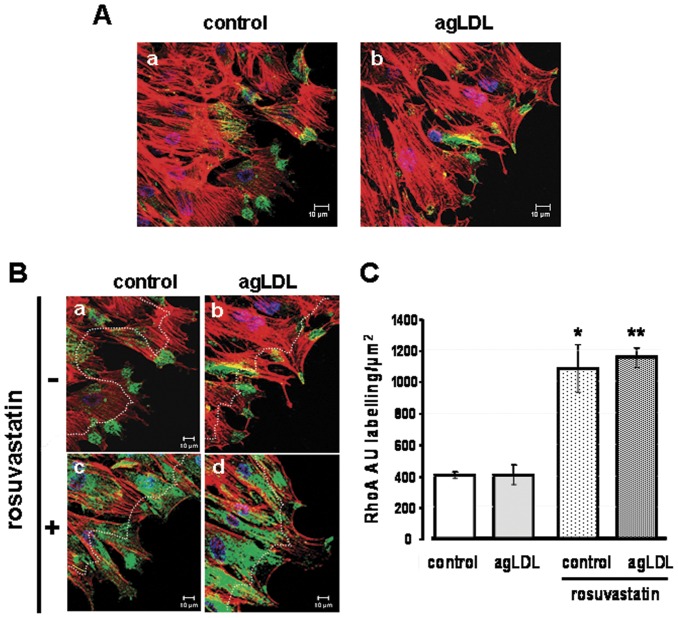
Rosuvastatin increases RhoA at the leading edge of migrating cells.Confocal microscopy for RhoA antigen labelling (green) in migrating cells (FCS-stimulated), 4 hours after the wound scratch. Immunocytology was performed in permeabilized cells. Red signal refers to F-actin (Alexa-Fluor 633 conjugated phalloidin). (A) Representative photomicrographs of RhoA labelling at the wound-border of control cells and agLDL-treated cells. (B) Effect of 10 µM rosuvastatin on RhoA localization at the leading-edge of control- and agLDL-VSMC. (C) Bar diagrams show quantitative levels (mean±SEM) of RhoA labelling over an area 15 µm wide, along the migrating edge (limited by dotted line in A). Intensity labelling signal was calculated using the LASAF Leica software and expressed in intensity/µm2 (results from 3 independent experiments). p<0.05 for (*) control+rosuvastatin vs control and (**) agLDL+rosuvastatin vs agLDL.